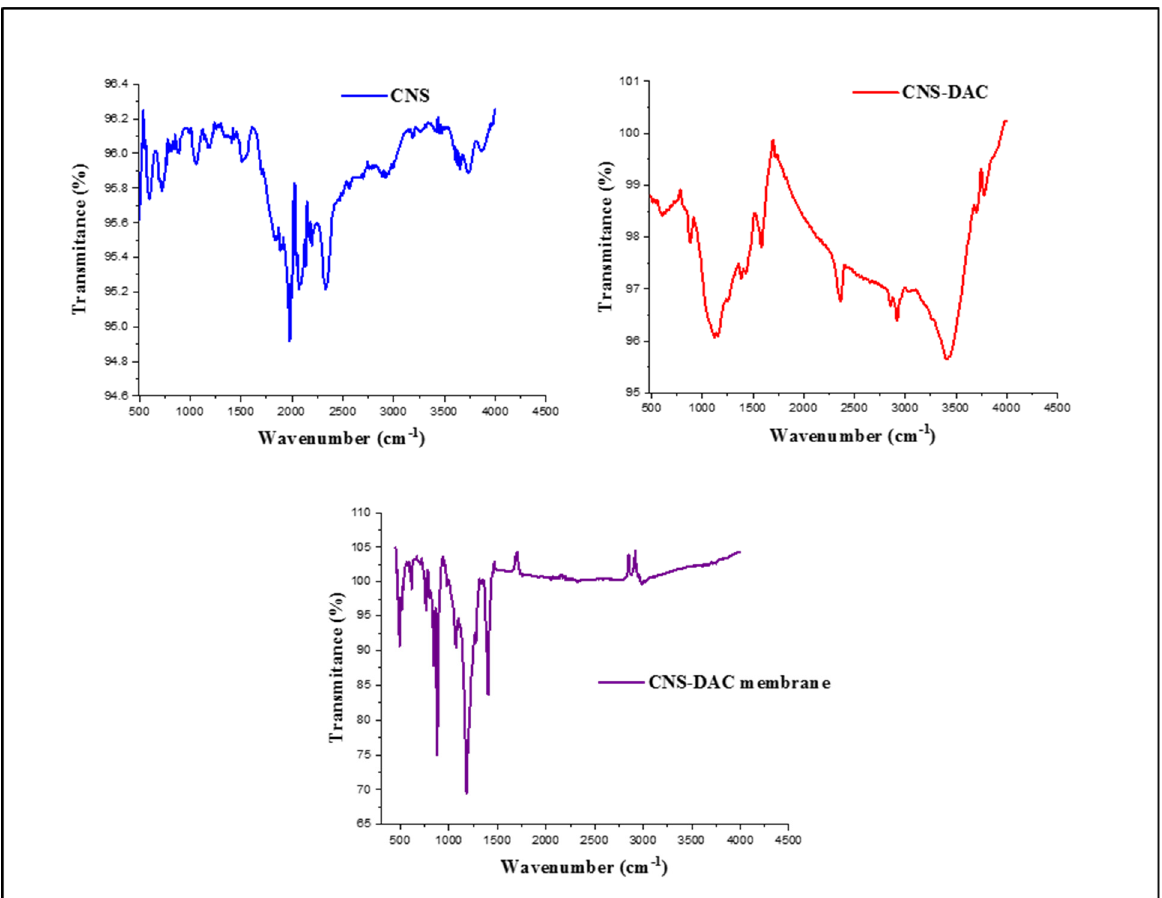
Figure 3. FTIR spectra of CNS, CNS-DAC, and a CNS-DAC membrane.